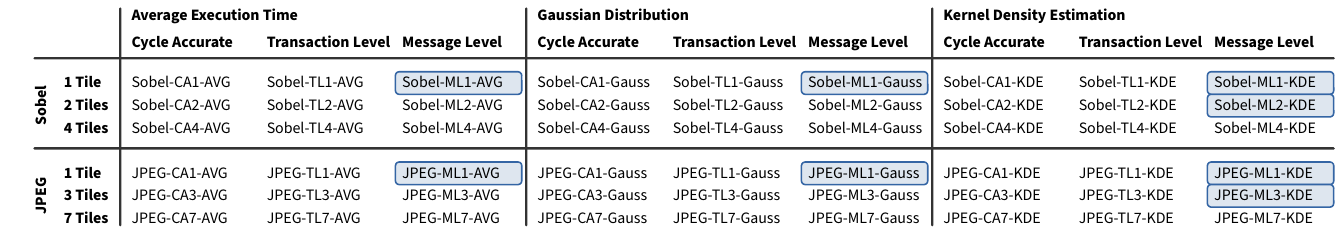
Figure 6. Overview of all experiments done using different computation and communication performance models. Experiments that challenge our approach are highlighted in blue and will be discussed in detail.